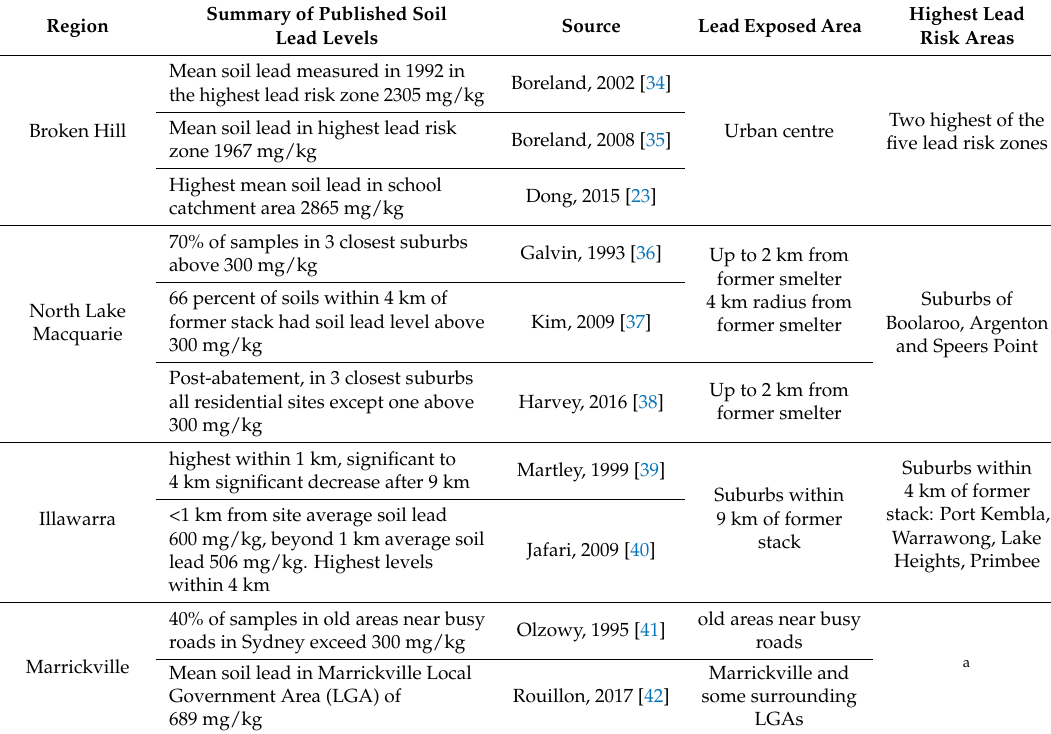
Table 1. Summary of lead exposure, with the soil lead levels, a brief description of the bounds of the lead exposed areas and the highest lead risk areas.